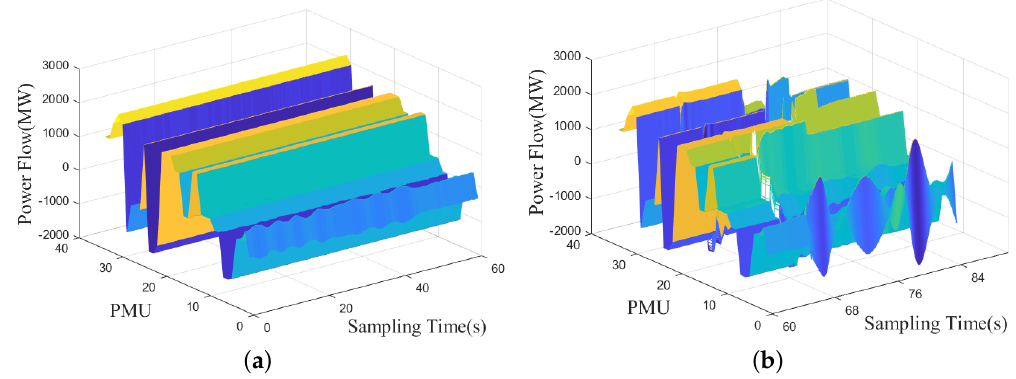
Figure 4. The real 34-PMU power flow data. ( a ) The real 34-PMU power flow data under normal conditions; ( b ) The real 34-PMU power flow data when the multiple event